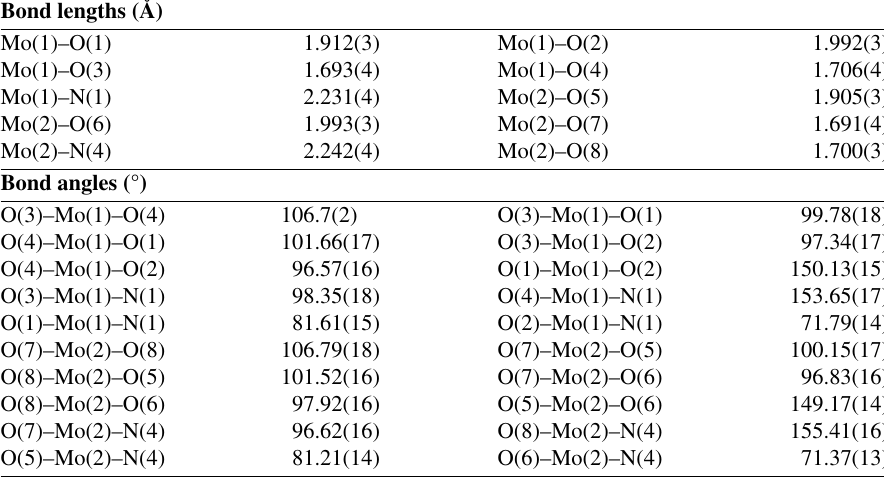
Table 2. Selected bond lengths (Å) and angles (°) for the